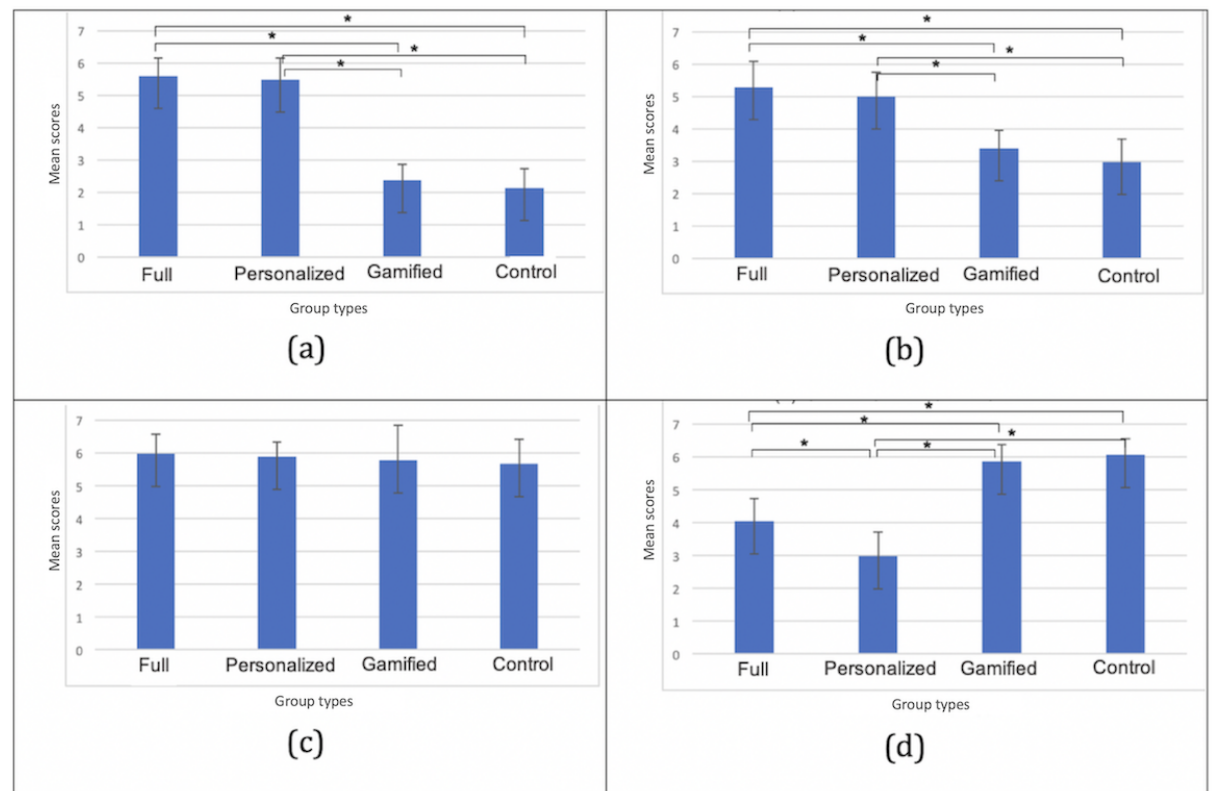
Figure 9. Average and SD of European Microsoft Innovation Center recommendation. From top to bottom: (a) perceived recommendation quality, (b) perceived system effectiveness, (c) general trust in technology, and (d) system-specific privacy